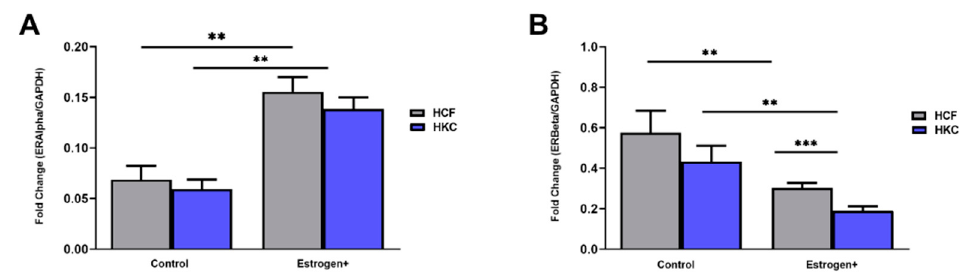
Figure 9. Expression of ER α and ER β in 3D HCFs and HKCs in response to estrogen+ (E1 and E3) stimulation for four weeks. ( A ) Overall ER α expression in HCFs and HKCs ( n = 6). ( B ) Overall expression of ER β in HCFs and HKCs ( n = 6). ** p < 0.01, and *** p < 0.001.